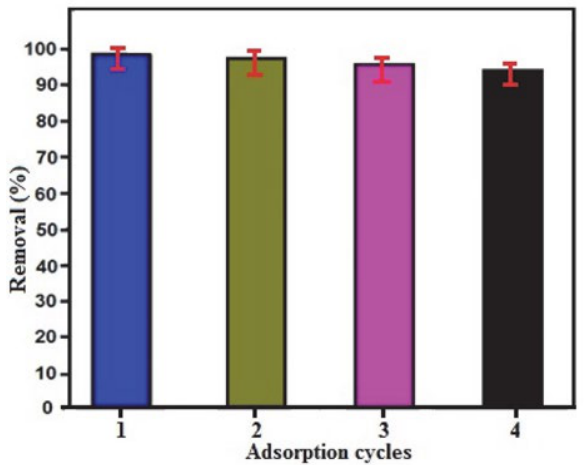
O /GO-NH /H PMo O hybrid nano- 3 4 2 3 12 40